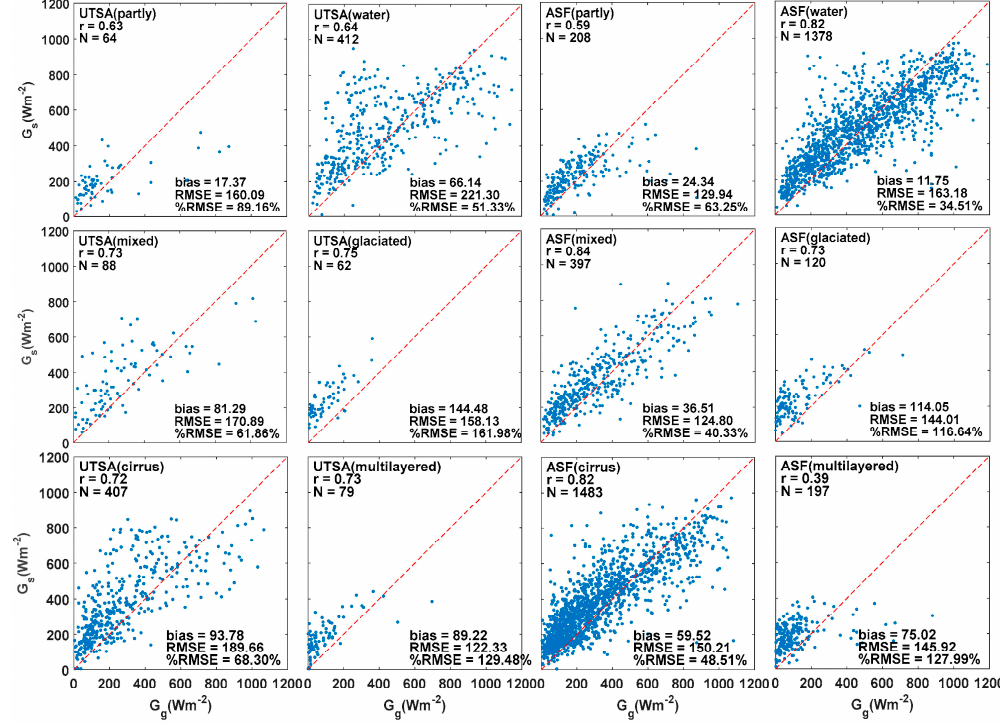
Figure 5. Scatter plots showing the correlation of G s versus G g for the six different cloud types at UTSA ( left two panels ) and ASF ( right two panels ).